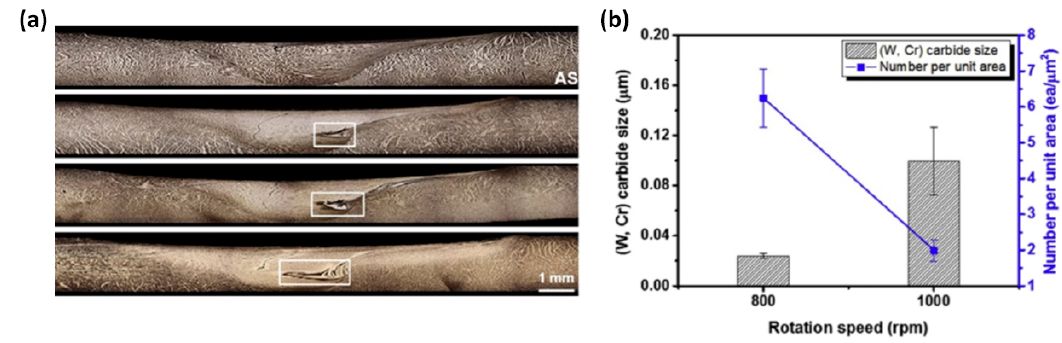
Figure 10. Characterization of friction stir welded (FSWed) CoCrFeNiMn joints: ( a ) Morphology of the welds at different rotation speeds (from top to bottom: 400, 600, 800, 1000 rpm); ( b ) carbide content at 800rpm and 1000 rpm (Adapted from [89], with permission from Elsevier, 2019).